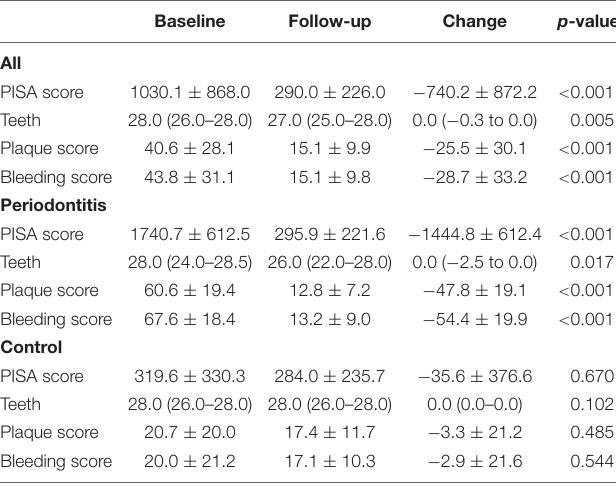
TABLE 2 | Changes in dental